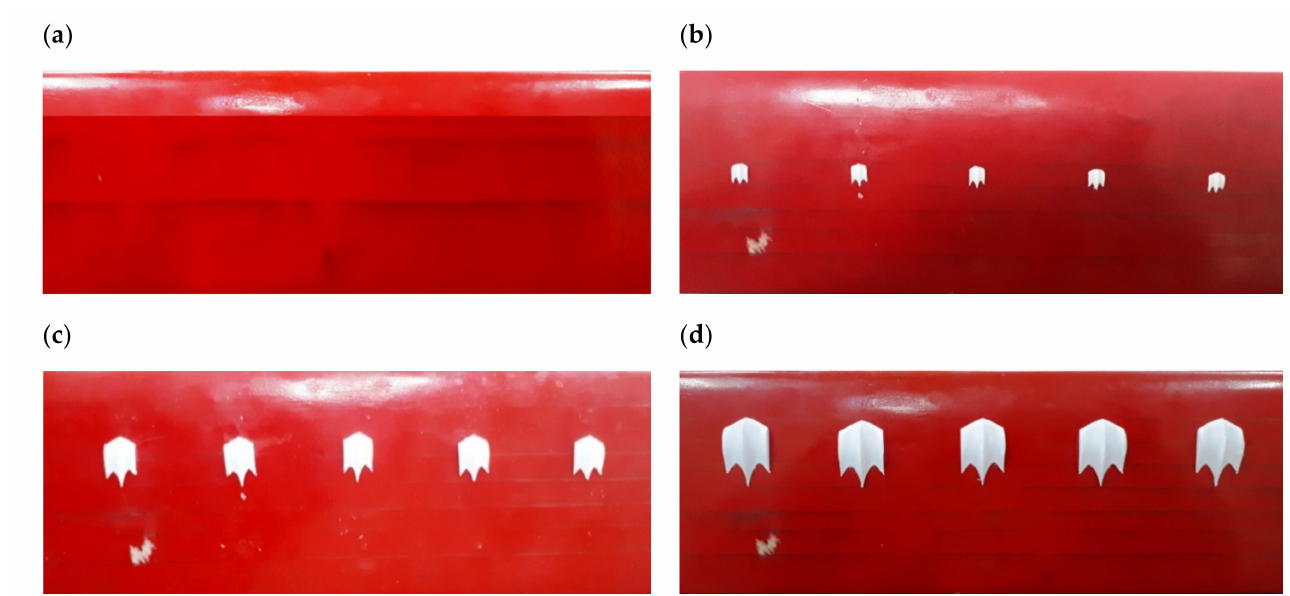
Figure 3. Photographs of baseline and modified wing model with shark scale vortex generator (SSVG): ( a ) baseline clean wing, ( b ) 5S type SSVG, ( c ) 5M type SSVG, and ( d ) 5L type SSVG.